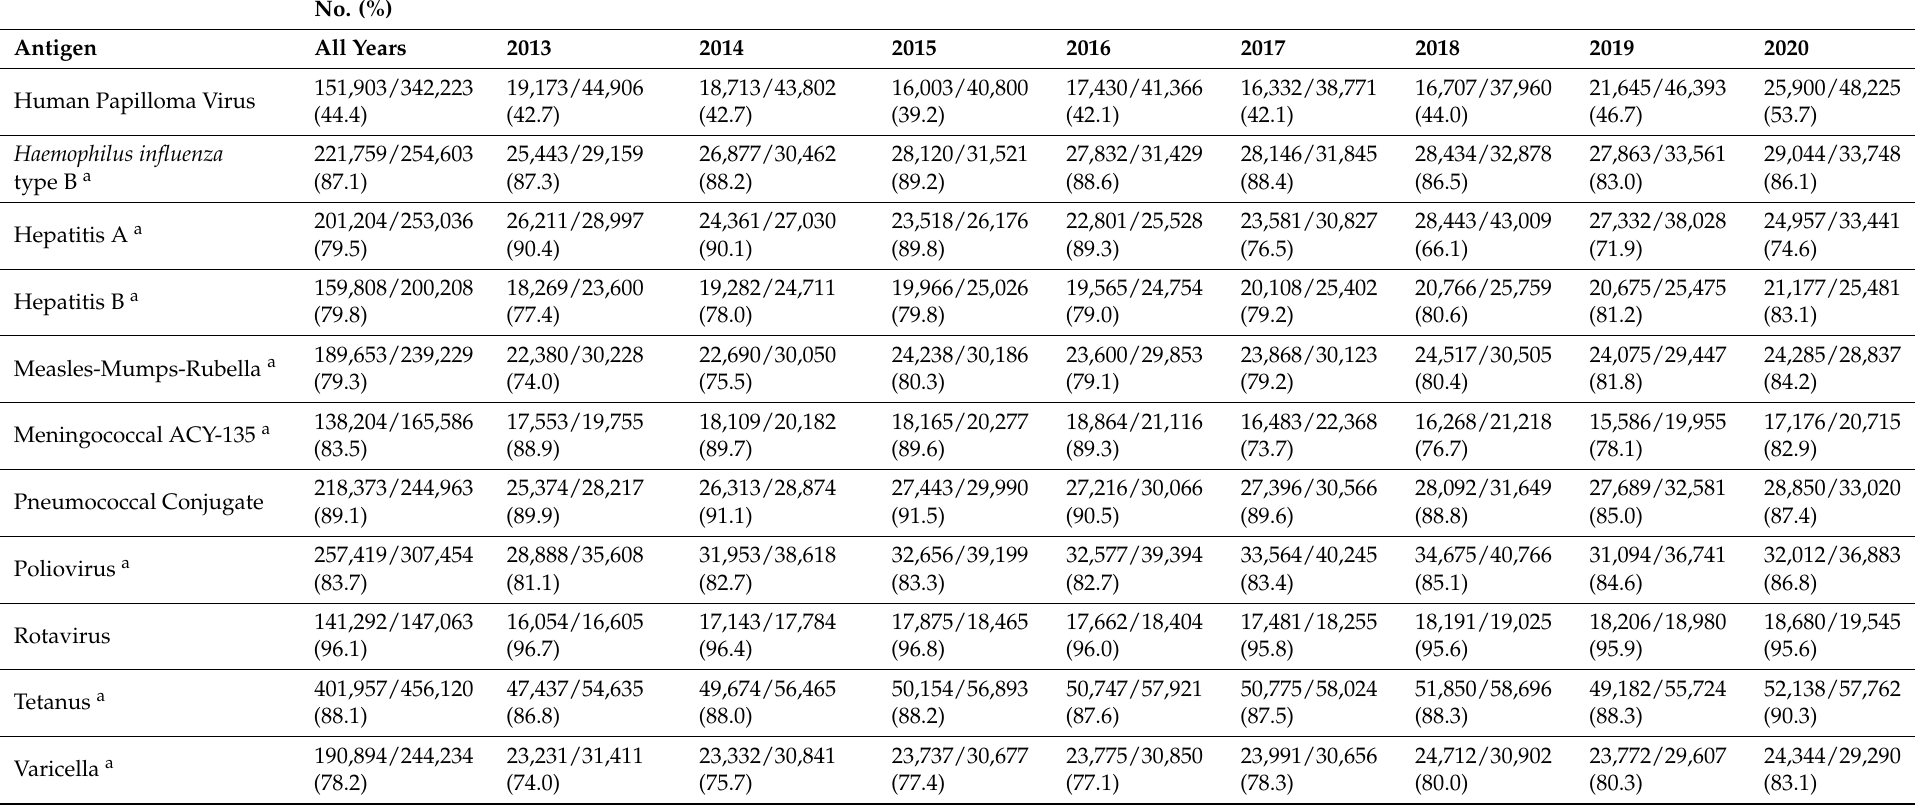
Table 5. Vaccine Acceptance Upon Provider Recommendation by Antigen,